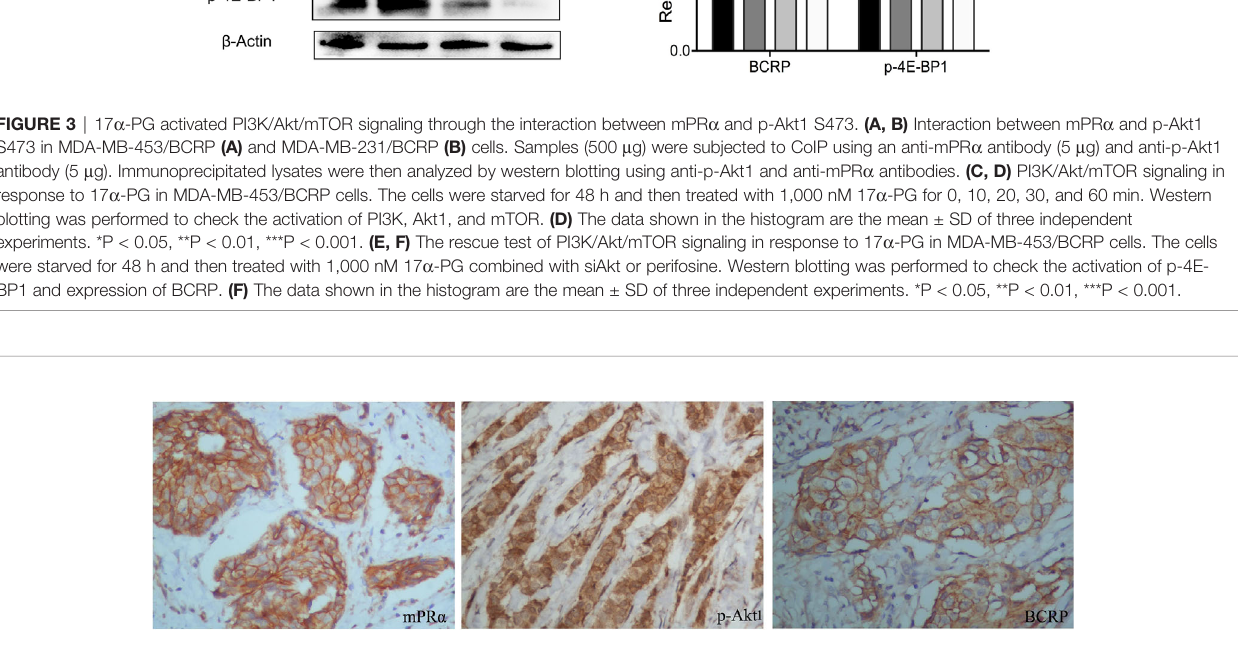
FIGURE 4 | BCRP expression was positively related to mPR a and p-Akt1 S473 in breast tissue. Representative BCa specimens positive for mPR a , p-Akt1 S473, and BCRP, as detected by IHC. Photographs were taken at ×400 magni fi cation. Invasive BCa positive for mPR a (left), p-Akt1 S473 (middle), and BCRP (right). Note that in BCa, mPR a and BCRP were detected at the membrane and/or in the cytoplasm, while p-Akt1 S473 was mainly detected in the